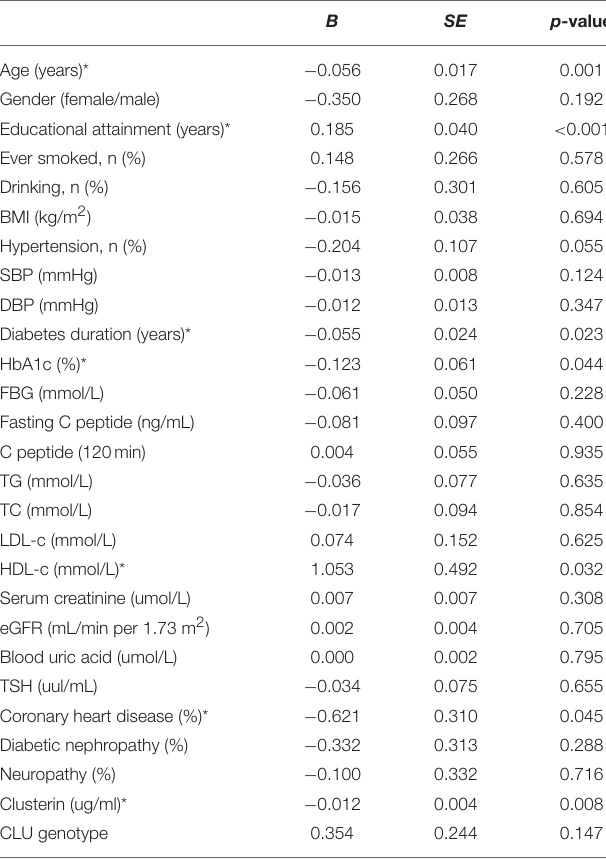
TABLE 6 | Assessment results of the risk of having MCI in a simple logistic regression model in T2DM